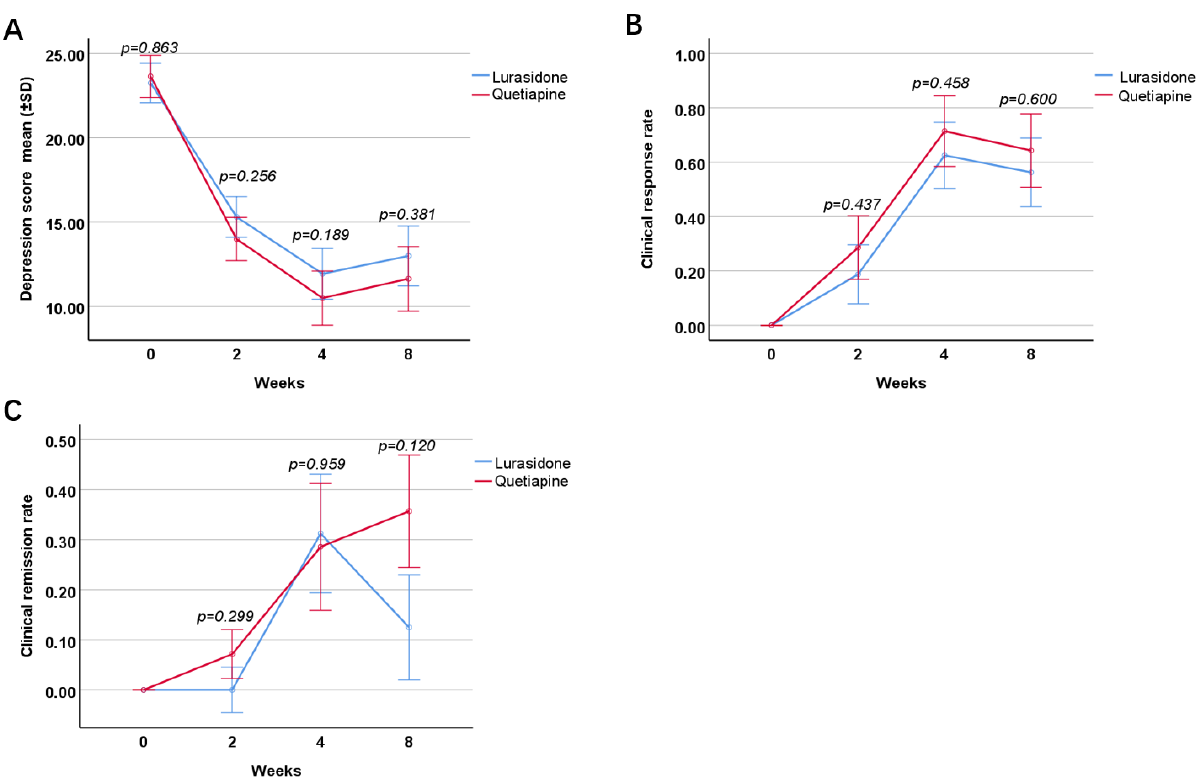
Figure 1. Improvement in depression following quetiapine or lurasidone treatment. Comparison of depression severity by HAMD scores between the two groups at baseline, and the end of week 2, 4 and 8 ( A ); comparison of clinical response rate between the two groups at the end of 2, 4, and 8 ( B ); comparison of clinical remission rate between the two groups at the end of 2, 4 and 8 ( C ).